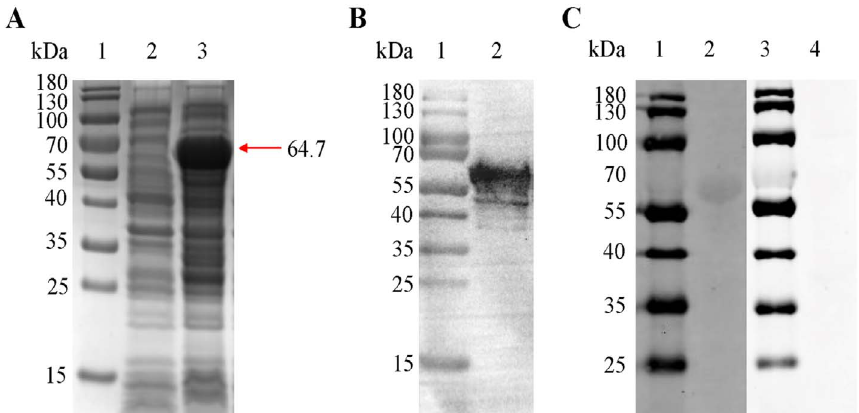
Figure 3. Expression and puri fi cation of r Et CHP18905. (A) SDS-PAGE analysis of the 5 r Et CHP18905. Lanes 1, protein marker; 2, negative control (not induced with IPTG); 3, the r Et CHP18905 protein with the GST-tag protein of the vector (induced with IPTG for 6 h). (B) Western blot analysis of puri fi ed r Et CHP18905 protein. Lane 2, protein recognized by an anti GST-Tag monoclonal antibody. (C) Western blot analysis of puri fi ed r Et CHP18905 protein. Lane 2, protein recognized by rabbit sera against sporozoite, lane 4 incubated with naïve rabbit serum.